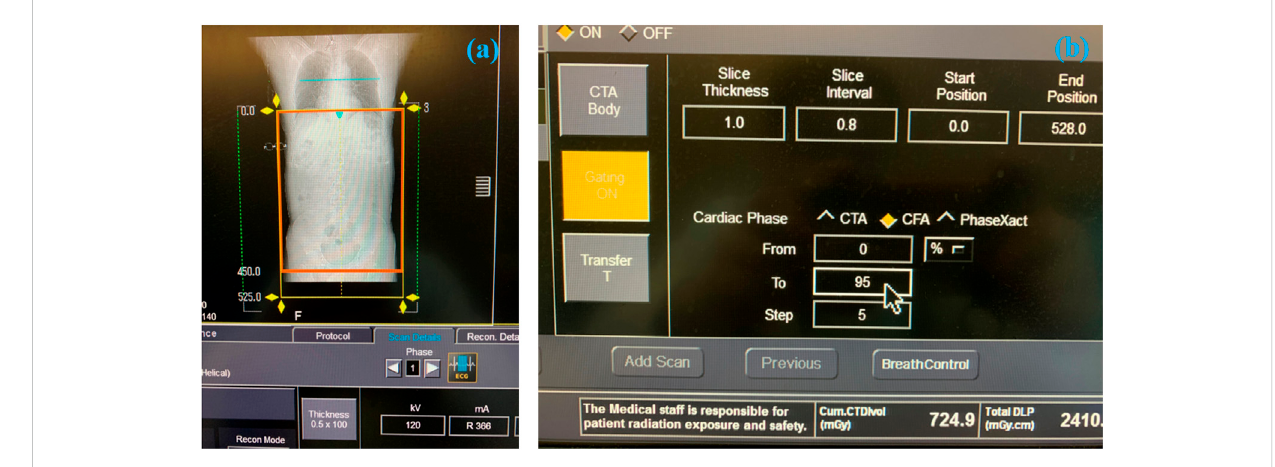
FIGURE 1 The process of obtaining the 4D CT image data. (A) The selected scanning range of AAA. (B) Parameters setting during scanning.